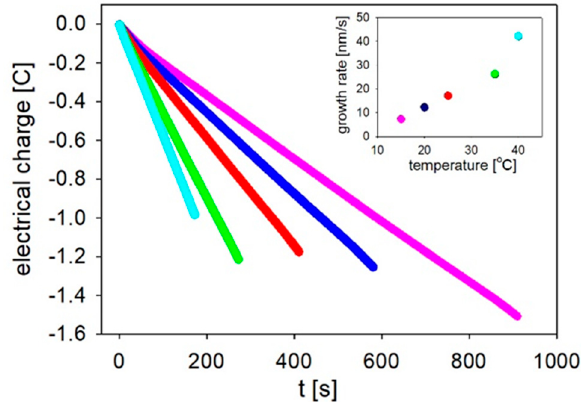
Figure 3. The electrical charge that was reduced into the porous membranes versus the time measured during the deposition of the Fe nanowires that were prepared at different electrolyte temperatures. The inset shows the growth rate as a function of the electrolyte temperature.